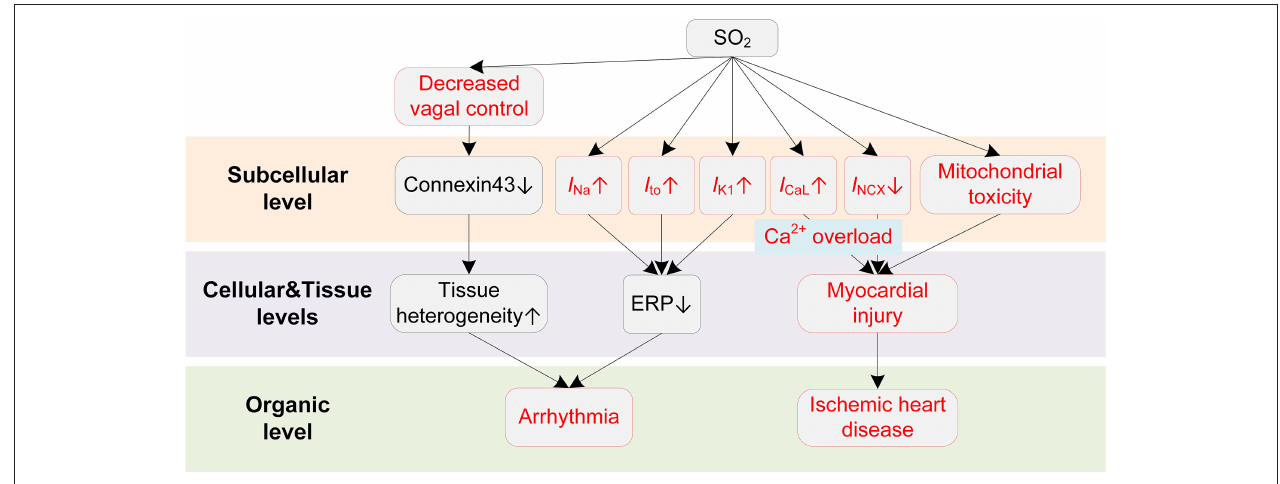
FIGURE 5 | Potential mechanisms underlying SO 2 -induced arrhythmias. Red boxes indicate effects of SO 2 that have been explicitly